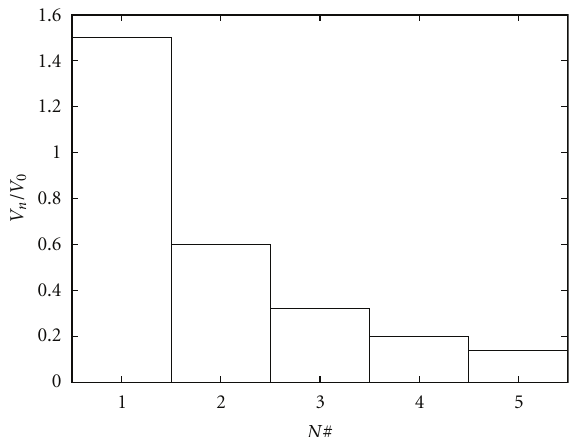
Figure 5: Normalized e ff ective volume V n /V 0 as a function of mode order.